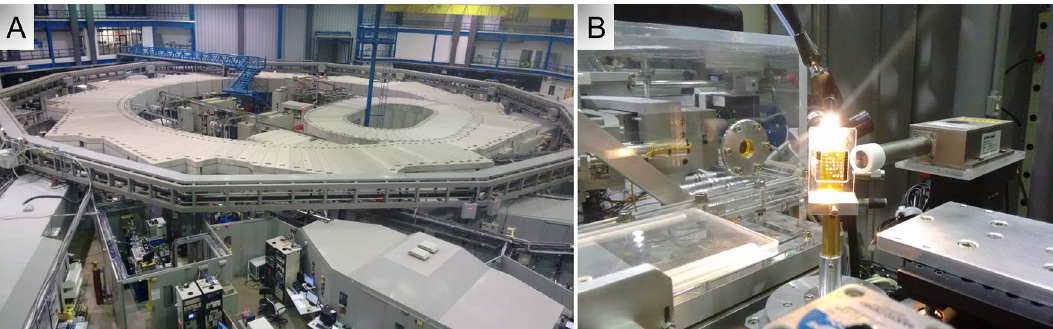
Figure 4. Cyclic accelerator of synchrotron light. ( A ) The synchrotron micro-X-ray fluorescence (µ-XRF) radiation was used to detect chemical elements from electron excitation energy absorption performed on the D09-XRF beamline in oral cancer samples, at the Brazilian Synchrotron Light Laboratory (LNLS), Campinas, SP, Brazil. ( B ) The samples they were deposited in plastic support with ultralene film the synchrotron radiation- matrix were